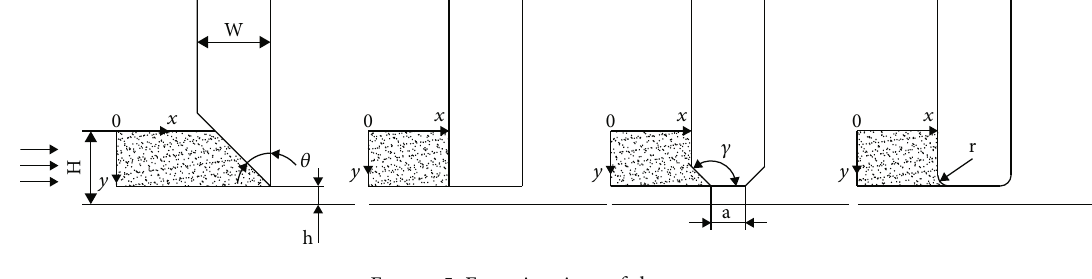
Figure 5: Four situations of the scrapers.